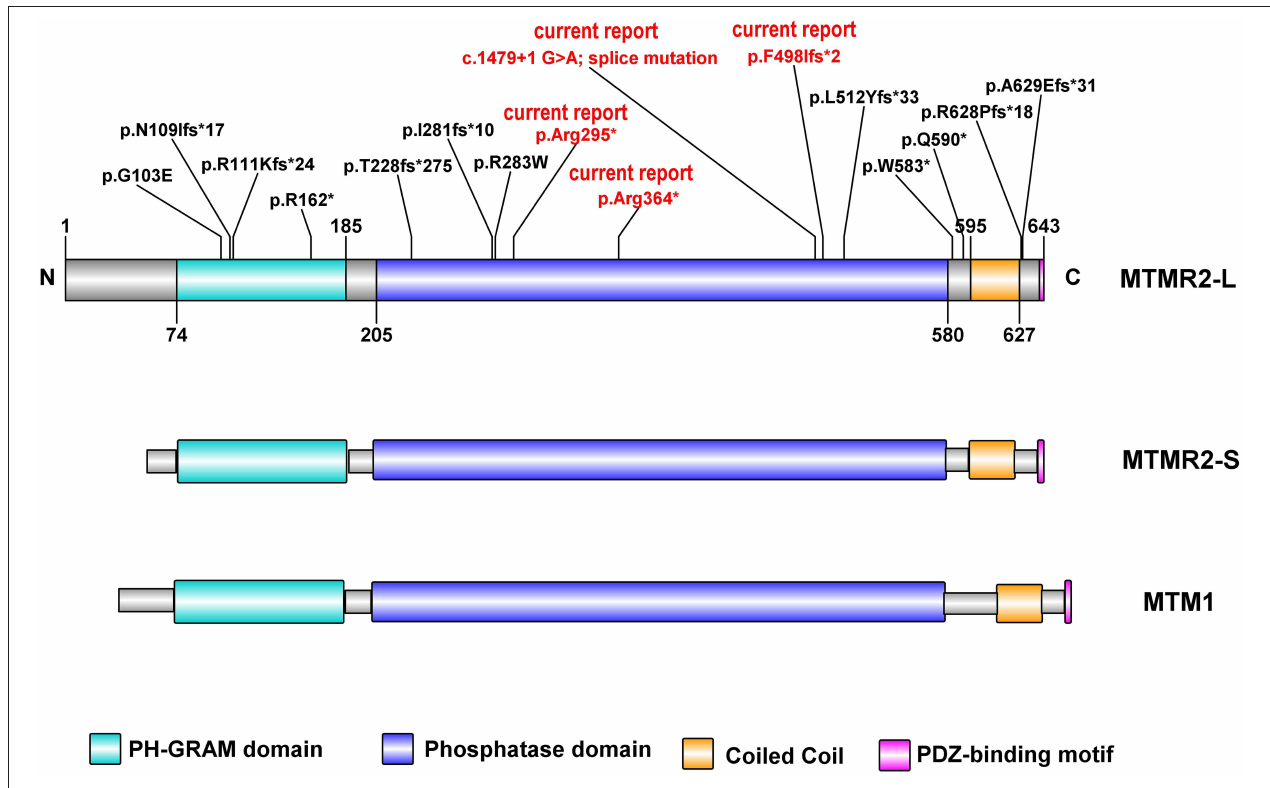
FIGURE 3 | Schematic representation of human MTMR2 protein domains (NP 057240.3) and position of the mutations identified so far, generated by Illustrator for Biological Sequences: IBS. In red are the reported novel mutations identified in our study. The MTMR2 long isoform (MTMR2-L), MTMR2 short isoform (MTMR2-S), and MTM1, all contain (Raess et al., 2017) PH-GRAM domain, phosphatase domain, Coiled-Coil domain, and PDZ binding motif. The two MTMR2 protein isoforms differ only in their translation start sites.